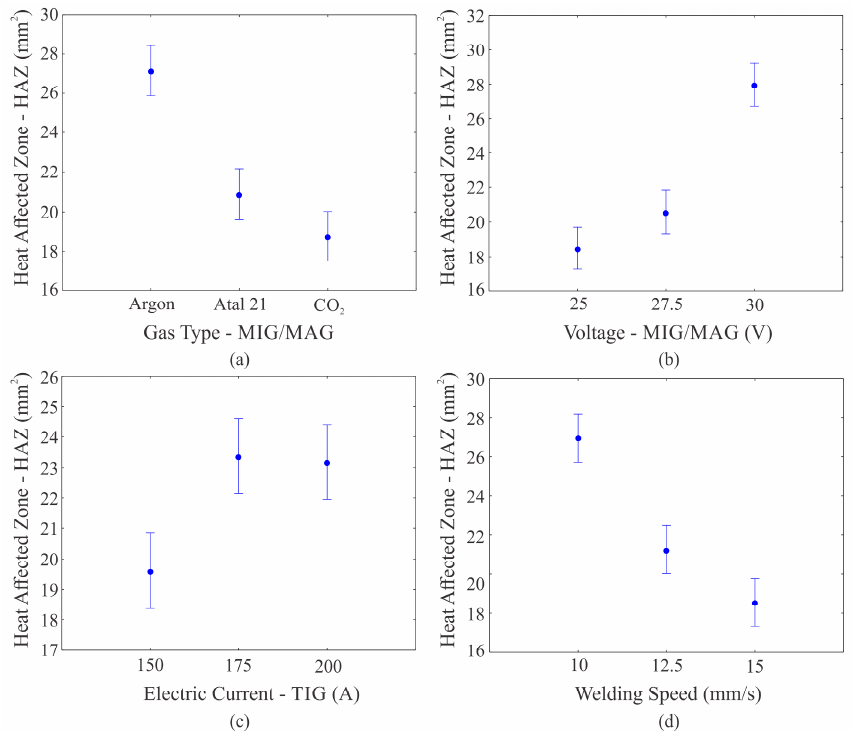
Figure 6. Effect of the solder factors on the heat-affected zone (HAZ).